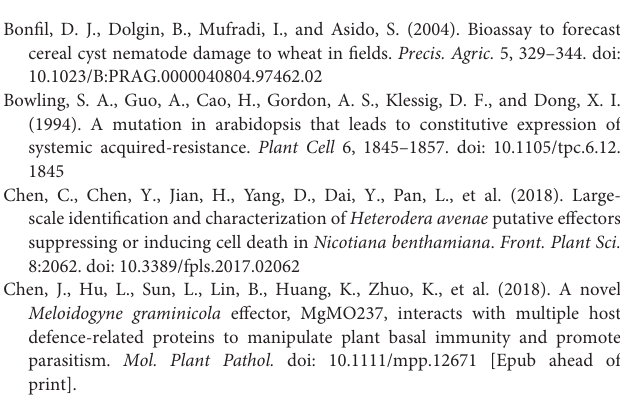
FIGURE S1 | Phylogenetic tree of G16B09 family members from different nematodes. For G. pallida , the genomic gene numbers are listed. For H. glycines and H. avenae , the GenBank accession numbers are listed after the gene names. Hg, H. glycines ; Ha, H. avenae ; Gp, G. pallida . FIGURE S2 | Suppression of BT-PCD by Heterodera avenae G16B09-like effector family in Nicotiana benthamiana . The N. benthamiana leaves were infiltrated with a buffer, or A. tumefaciens cells carrying the candidate gene, or the negative control eGFP gene, either alone or 24 h prior to infiltration with A. tumefaciens cells carrying Bax . Photographs of infiltrated leaves were taken ca. 4 days after the last infiltration. Numbers in parentheses indicate the proportion of infiltrated sites showing cell-death-suppressing symptoms. Shown below is the verified protein expression of H. avenae proteins, eGFP, and Bax, by Western blotting. FIGURE S3 | The original Western blotting images embedded into Figure 6 . The expression of GFP or Ha18764 were verified using anti-flag. All bands are labeled with a black line. FIGURE S4 | The original Western blotting images embedded into Figure 6 . The expression of MKK1, NPK1 Nt or NIP were verified using anti-HA. All bands are labeled with a black line. FIGURE S5 | The original Western blotting images embedded into Figure 7 . The expression of GFP or Ha18764 were verified using anti-flag. All bands are labeled with a black line. FIGURE S6 | The original Western blotting images embedded into Figure 7 . The expression of Ha16511, Ha19390, Ha12969 or Ha16978 were verified using anti-HA. All bands are declared with a black line. FIGURE S7 | Sequence analysis of Heterodera avenae G16B09-like effector family. (A) Alignment of H. avenae G16B09-like effector family. (B) Phylogenetic tree of G16B09-like family members from H. avenae . TABLE S1 | List of all the primer sequences used in this